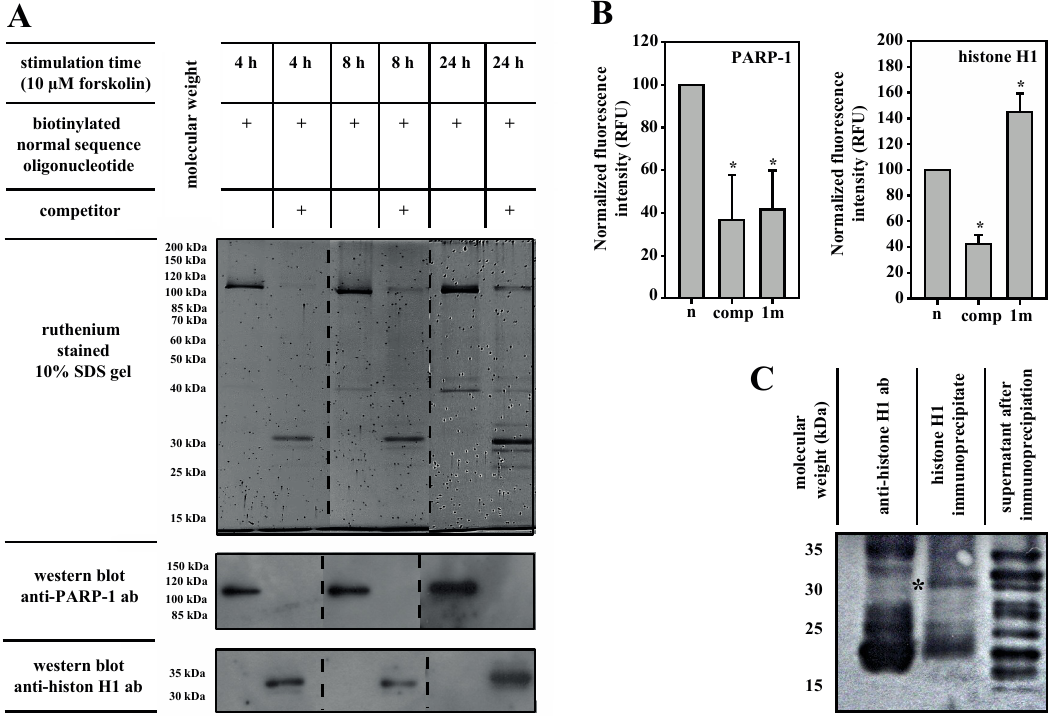
Figure 3. PARP-1 and histone H1 are part of a regulatory system. ( A ) Putative binding proteins in 200 µ g soluble nuclear extract of 3T3-L1 cells were purified using magnetic dynabeads ® M-280 streptavidin. The beads bound 133 pmol biotinylated oligonucleotides, either alone or in the presence of a 10-fold molar excess of an unlabeled normal sequence oligonucleotide (competitor). After this, SDS-PAGE-bound proteins were detected by ruthenium-staining and subsequent western blotting. The addition of a competitor displaced PARP-1 and enabled histone H1 binding. ( B ) PARP-1 or histone H1 isolated from soluble nuclear extracts of 3T3-L1 cells by immunoprecipitation bound to wild-type sequence probe (n). Binding to the fluorescent probe was inhibited by the competitor (comp). The SNV-containing fluorescent probe (1m) revealed reduced binding to PARP-1 but increased binding to histone H1 ( n = 3, * p < 0.05 for comp or 1m versus n). ( C ) Western blot using immunoprecipitated histone H1 from 3T3-L1 cell soluble nuclear extract. Parylation was detected by parylation-specific antibodies. In lane 1, anti-histone H1 ab indicates the loading of an excess of the pure antibody used for immunoprecipitation. The asterisk marks the 32 kDa-band of parylated histone H1.